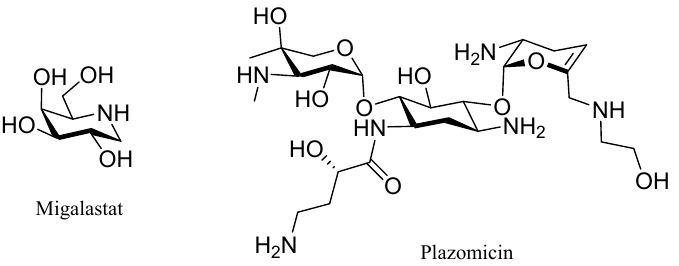
Figure 5. Structure of carbohydrate derived drugs.